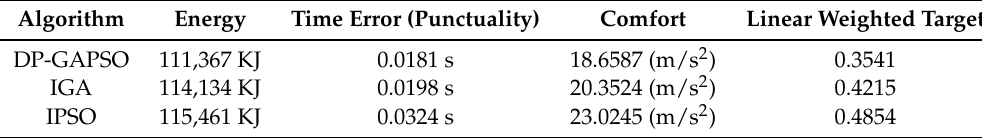
Figure 16. The operating condition distance curve of the train from Dalian North Station to Houyan. Table 12. The optimization results obtained by three different optimization algorithms from Dalian North Station to